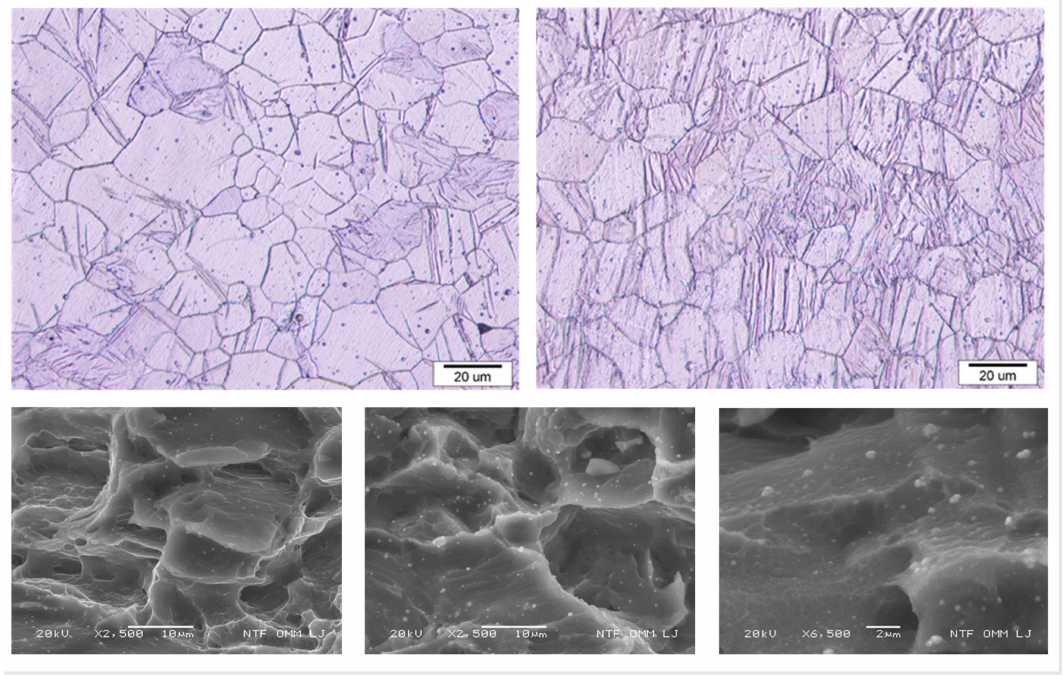
Figure 8. Microstructure of AZ31 specimen by optical microscopy for tensile loading (top left) and low-cycle fatigue loading (top right) and fracture surfaces by SEM for tensile loading (bottom left) and low-cycle fatigue loading (bottom middle and bottom right). Comparison of the microstructure after tensile stress and after low-cycling fatigue clearly shows the difference in the portion of twins remaining in the